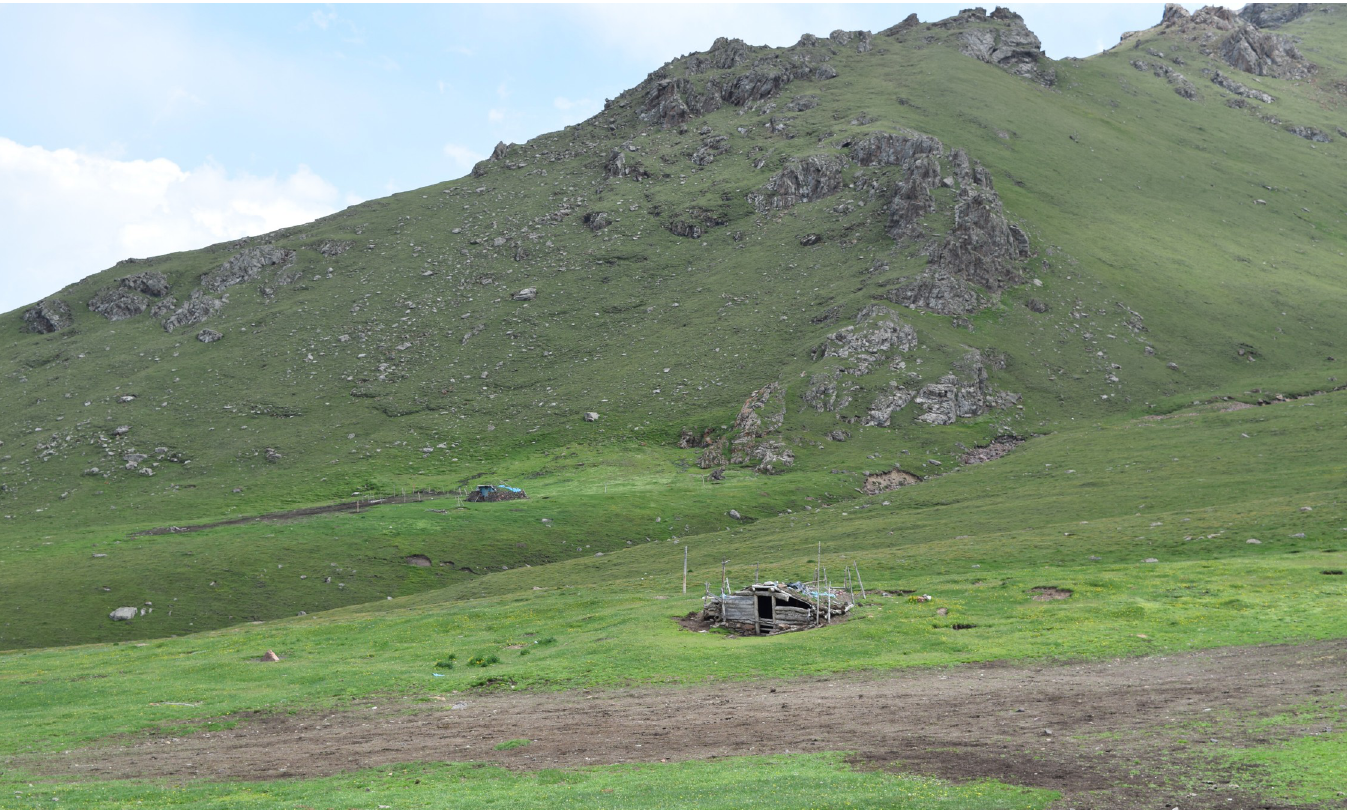
Fig 7. Wenquan herder Bangba’s summer camp at Big Angji, a high-altitude summer pastureland (2700 m a.s.l.) (P. Jia).